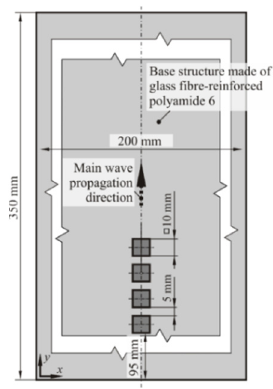
Figure 4. General overview of the elaborated model with geometrical interpretation of the modifiable parameters.